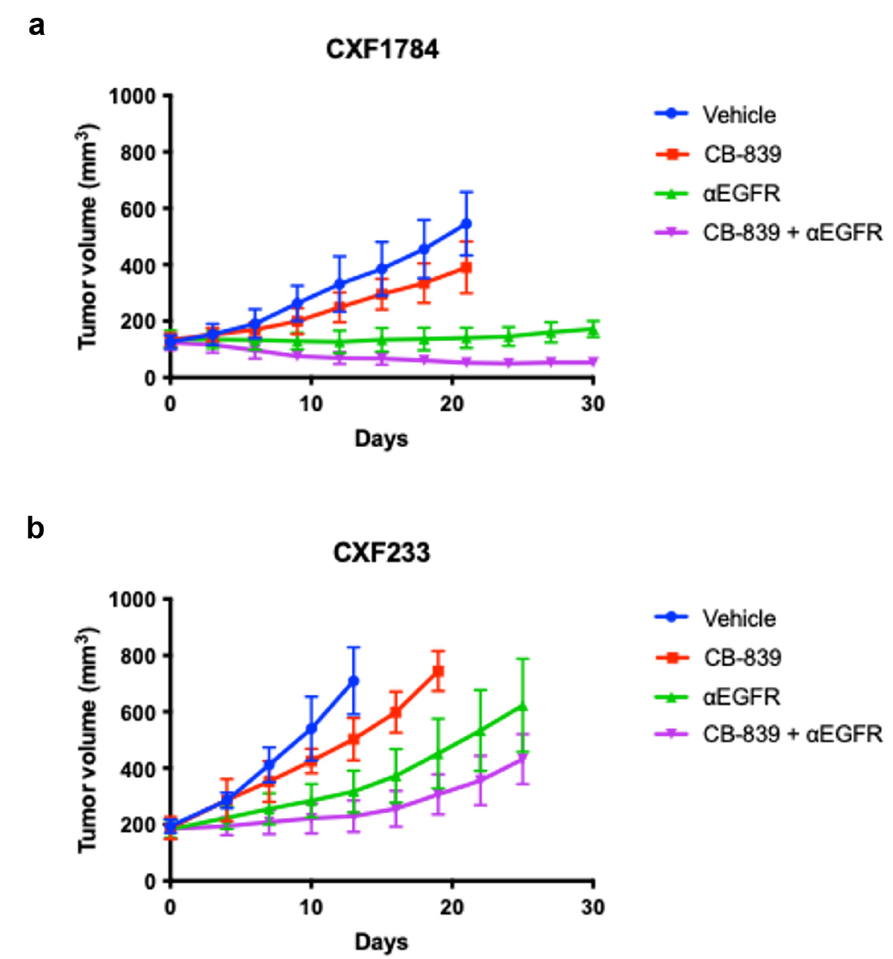
Figure 2. Treatment of WT KRAS PDX with a glutaminase inhibitor, α EGFR mAb, or the combination. PDX murine models were treated with either α EGFR monoclonal antibody (mAb), CB-839, or CB-839 and α EGFR. Error bars represent ± standard deviation (SD) ( n = 5). ( a ) CXF1784 PDX was responsive to α EGFR or the combined therapy. ( b ) CXF233 PDX lacked response beyond growth delay with α EGFR or the combined